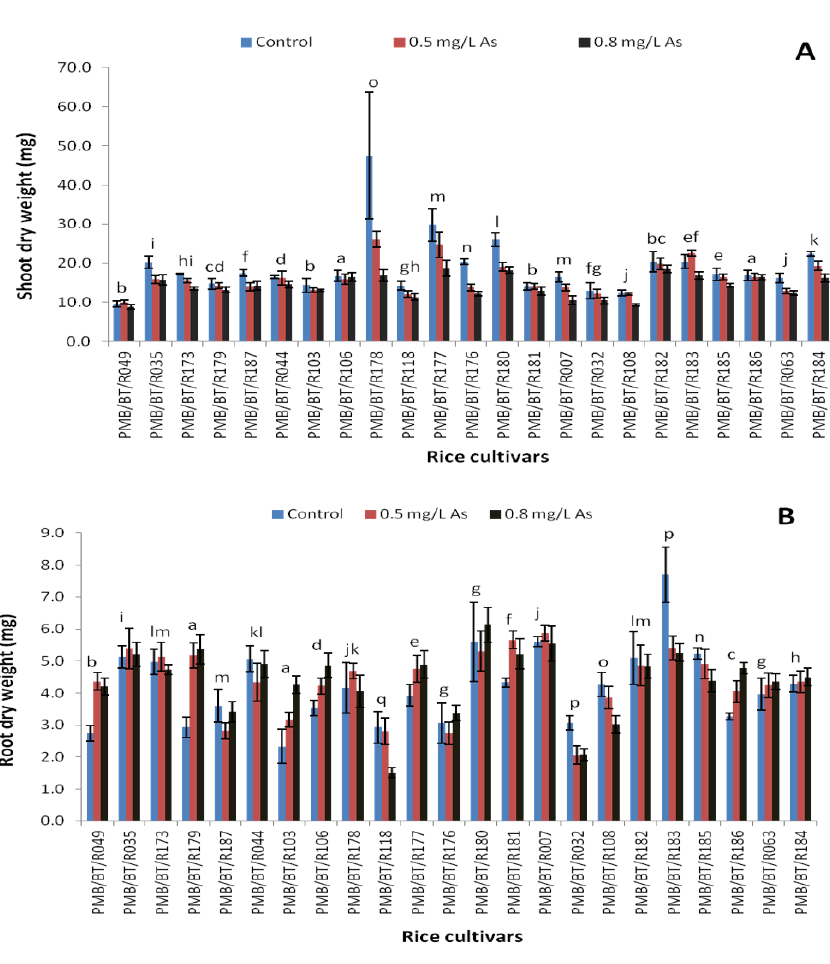
Figure 3 Shoot ( A ) and root ( B ) dry weights (mg) under arsenic stress. Data are presented as the mean ± SE ; n = 3. Columns topped by the same letter(s) indicate that the percentage changes in the parameter values of the presented cultivars under 0.8 mg/L arsenic stress do not differ significantly at the 5% level according to Duncan’s multiple-range